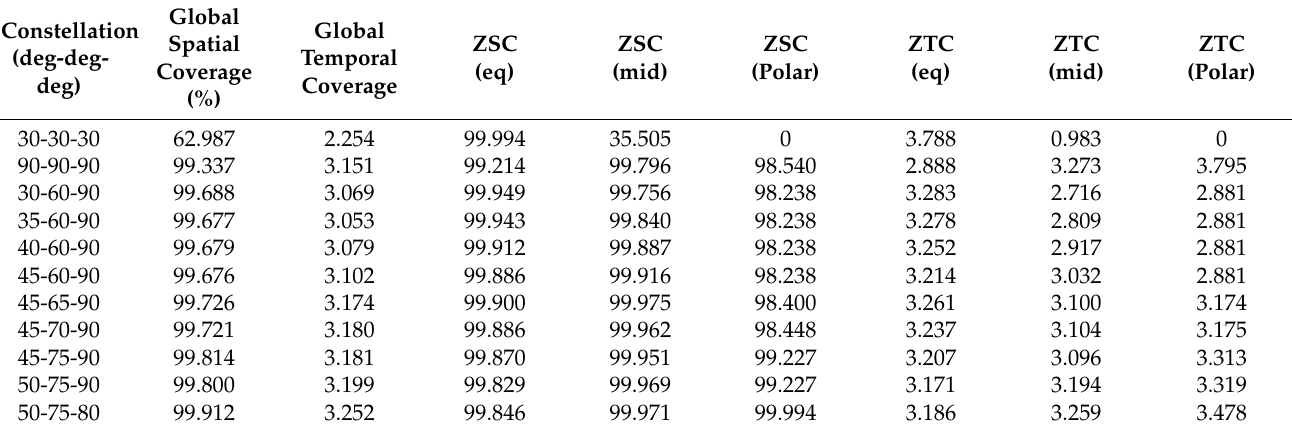
Table 1. Constellation Optimization through the Proposed Iterative Method. The constellations all feature 3 evenly distributed orbit planes of 8 evenly spaced satellites per plane at an altitude of 800 km. The coverage metrics described above were evaluated with the 3 × 5 element phased array antenna and a RCG minimum threshold of 15. By making these discrete adjustments in the inclinations of individual planes, we can keep the GSC near 100% while incrementally improving the